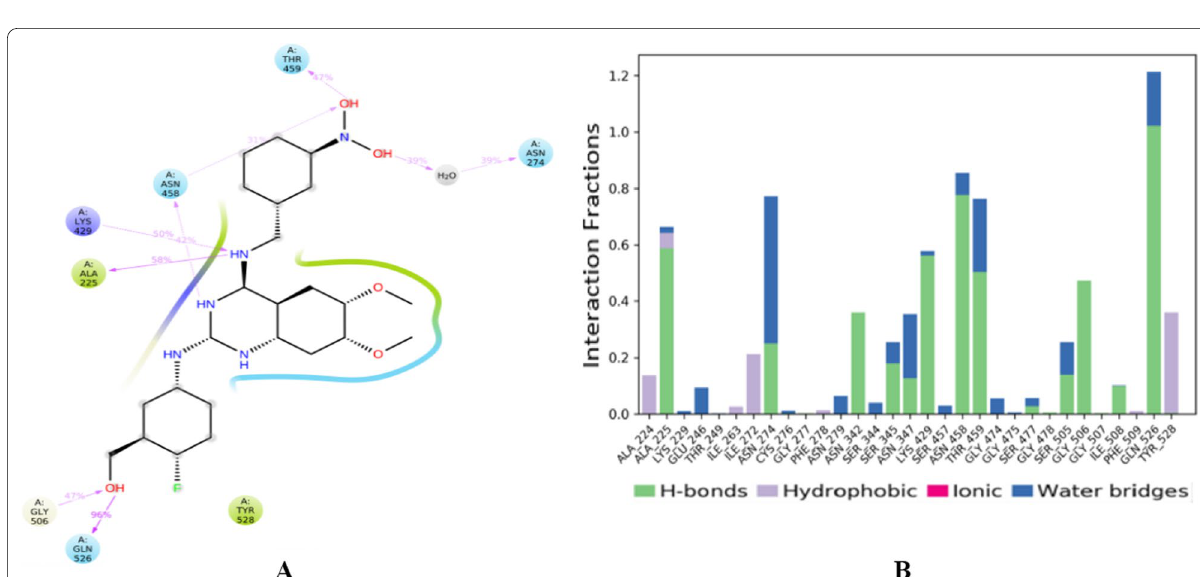
Fig. 4 Molecular interaction analysis and type of contact with Plasmodium falciparum dihydroorotate dehydrogenase, after MD simulation. The interaction of derivative C-02 atoms with binding site residue of Pf- DHODH (4CQ8) ( A ). Normalized stacked bar chart of Pf- DHODH binding site residues interacting with derivative C-02 ( B ) through hydrogen bond, hydrophobic and ionic interactions, and water